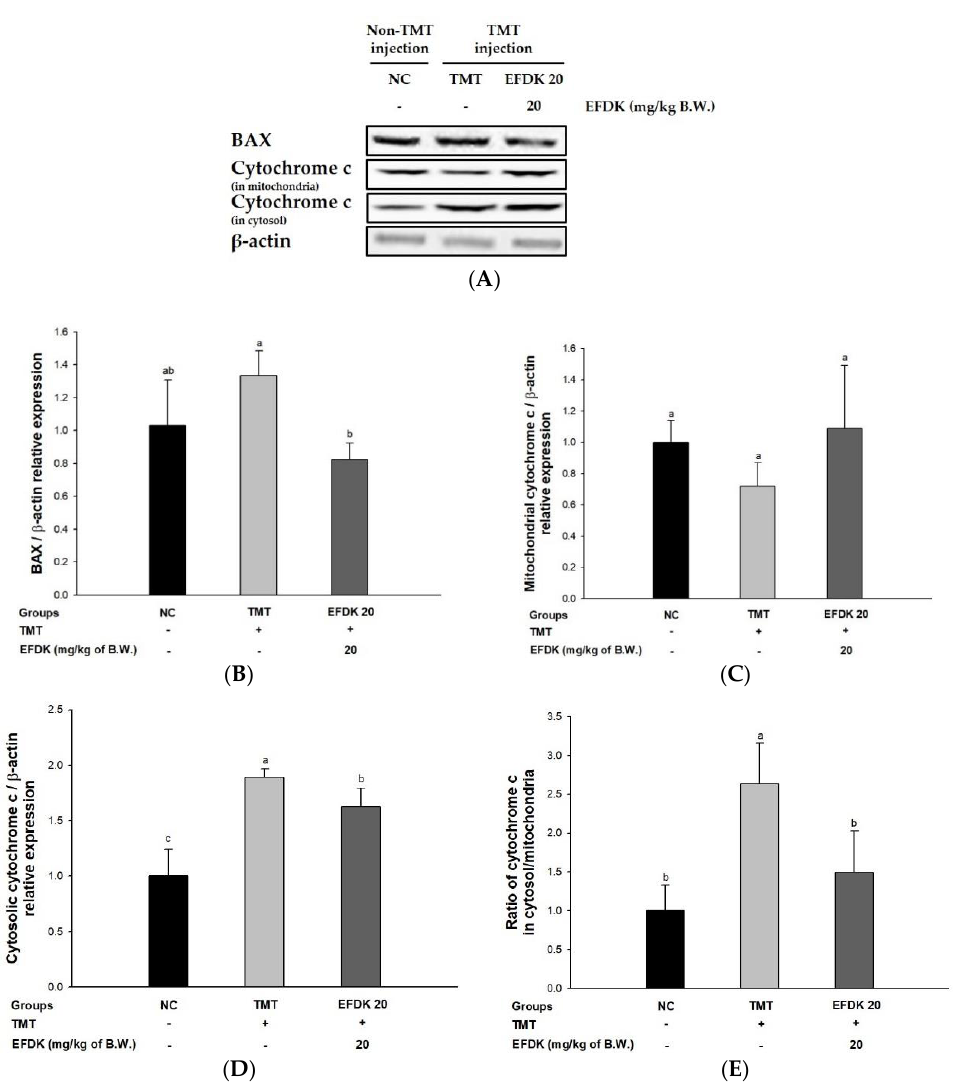
Figure 9. Protective effect of ethyl acetate fraction from persimmon (EFDK) on apoptotic pathway in mice brain tissues. ( A ) Representative Western blots for total protein and expression of BAX, mitochondrial cytochrome c, cytosolic cytochrome c and β-actin; Protein expression levels of BAX ( B ); mitochondrial cytochrome c ( C ); cytosolic cytochrome c ( D ) and ratio of cytochrome c in cytosol/mitochondria ( E ) normalized to β-actin. Results shown are mean ± SD ( n = 3). Data were statistically represented at p < 0.05, and different small alphabets mean statistical significance.